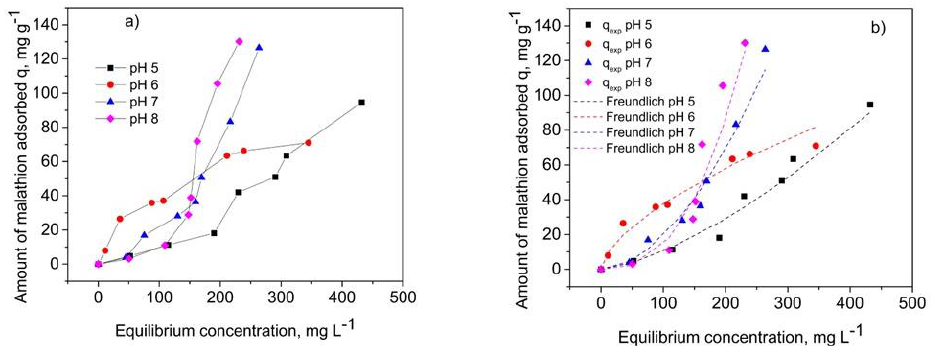
Figure 5. Adsorption equilibrium of malathion uptake by SG-LGPS at varying solution pHs, 298 K: ( a ) experimental data; ( b ) fittings to Freundlich isotherms (dashed lines).